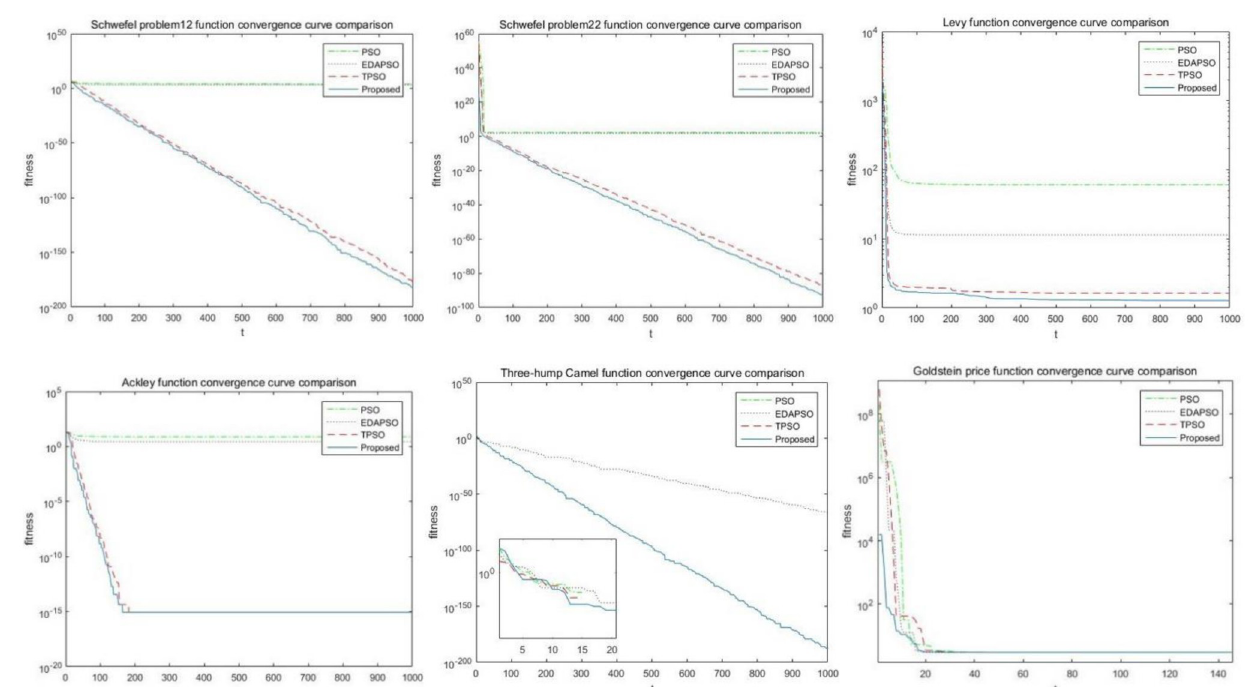
Fig 3. Comparison of convergence curves of six different test